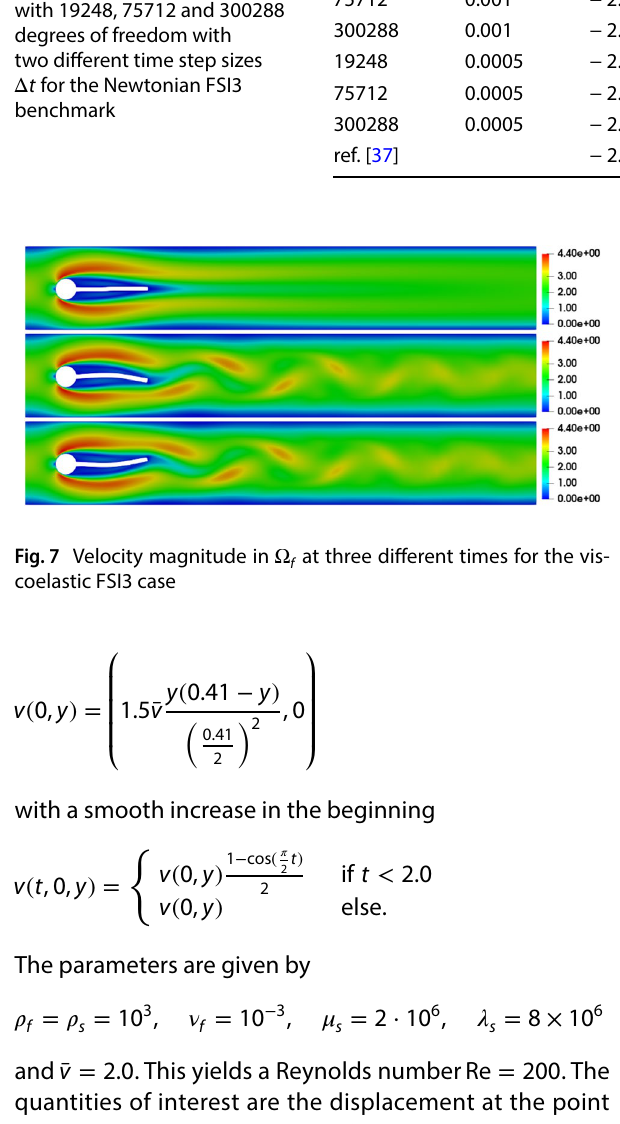
Table 2 Results for the quantities of interest for the mean and the amplitude on four different mesh levels with 11044, 42336, 165664 and 655296 degrees of freedom with two different time step sizes Δ t for the viscoelastic FSI3